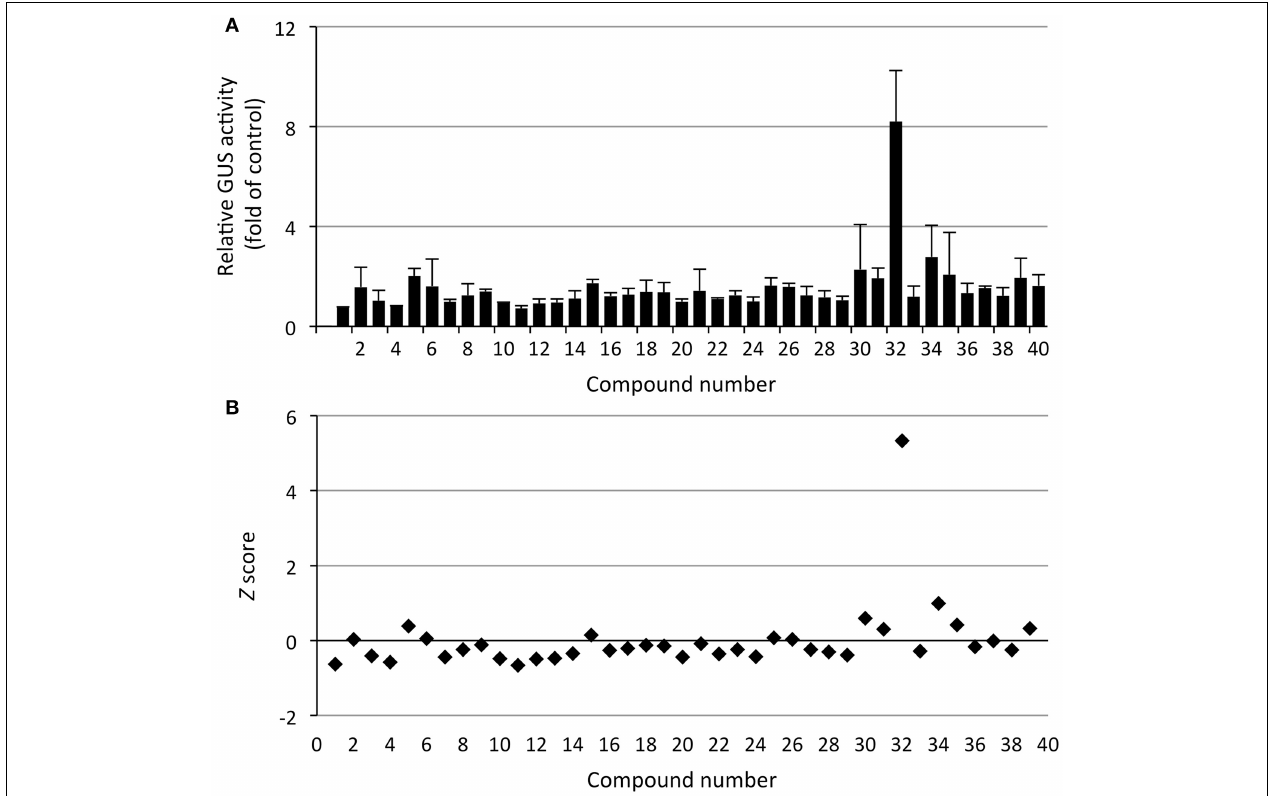
FIGURE 7 | Screening for activators of SA signaling. Arabidopsis seedlings harboring the SA-responsive PR1p::GUS reporter gene, grown for 12 days in liquid culture, were treated with 40 diverse chemicals (20 μ M) for 24h. (A) GUS activity of whole seedlings ( in situ ) was quantified by incubation with 4-MUG (1mM) for 90min (see Materials and Methods) and normalized to the control samples (DMSO treated). Values represent the mean of duplicate samples and the error bars indicate the corresponding high and low values.